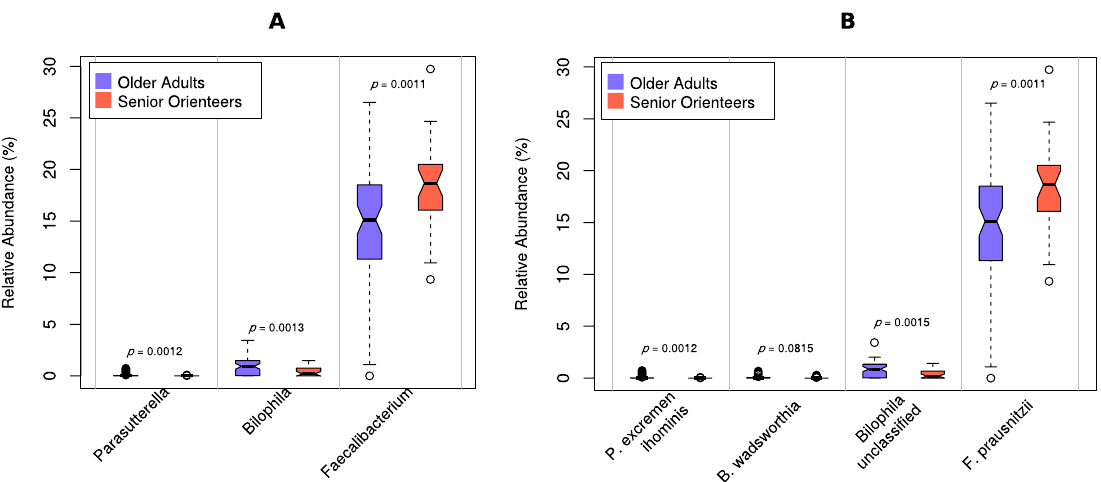
Figure 3. Relative abundance of significantly different genera and selected species stratified for group (senior orienteers compared to older adults). Cut-off for significance was set at false discovery rate (FDR) <5%. Descriptive p -values for each comparison are shown. (A) Genera; (B) Species.